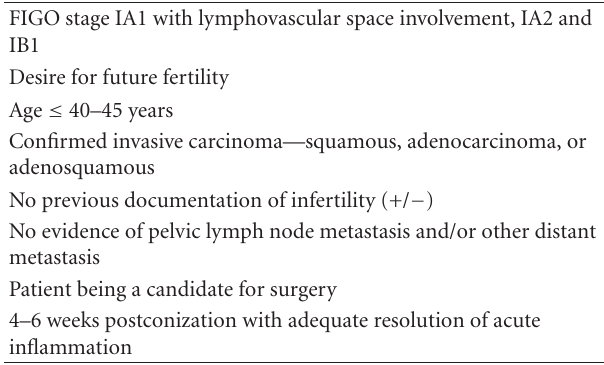
Table 1: Eligibility criteria for radical trachelectomy. FIGO stage IA1 with lymphovascular space involvement, IA2